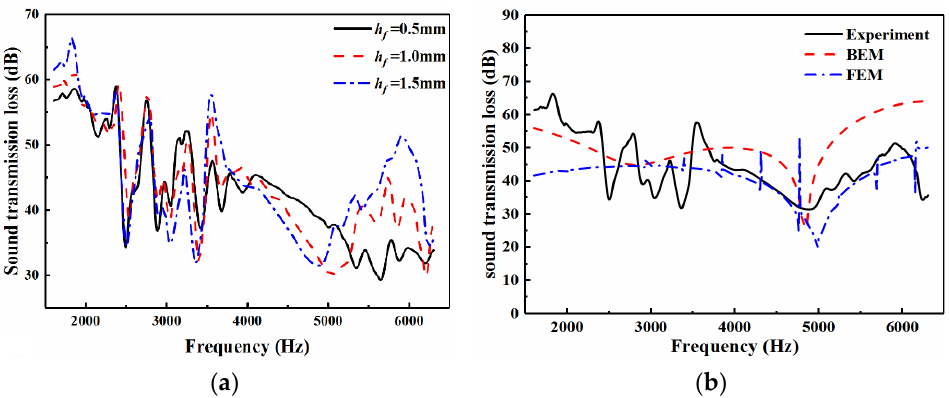
Figure 12. Experimental and simulated STL results for type B structures, showing: ( a ) test results for three structures with plates of different thickness; and ( b ) a comparison of the test and simulated results for the B 3 structure .